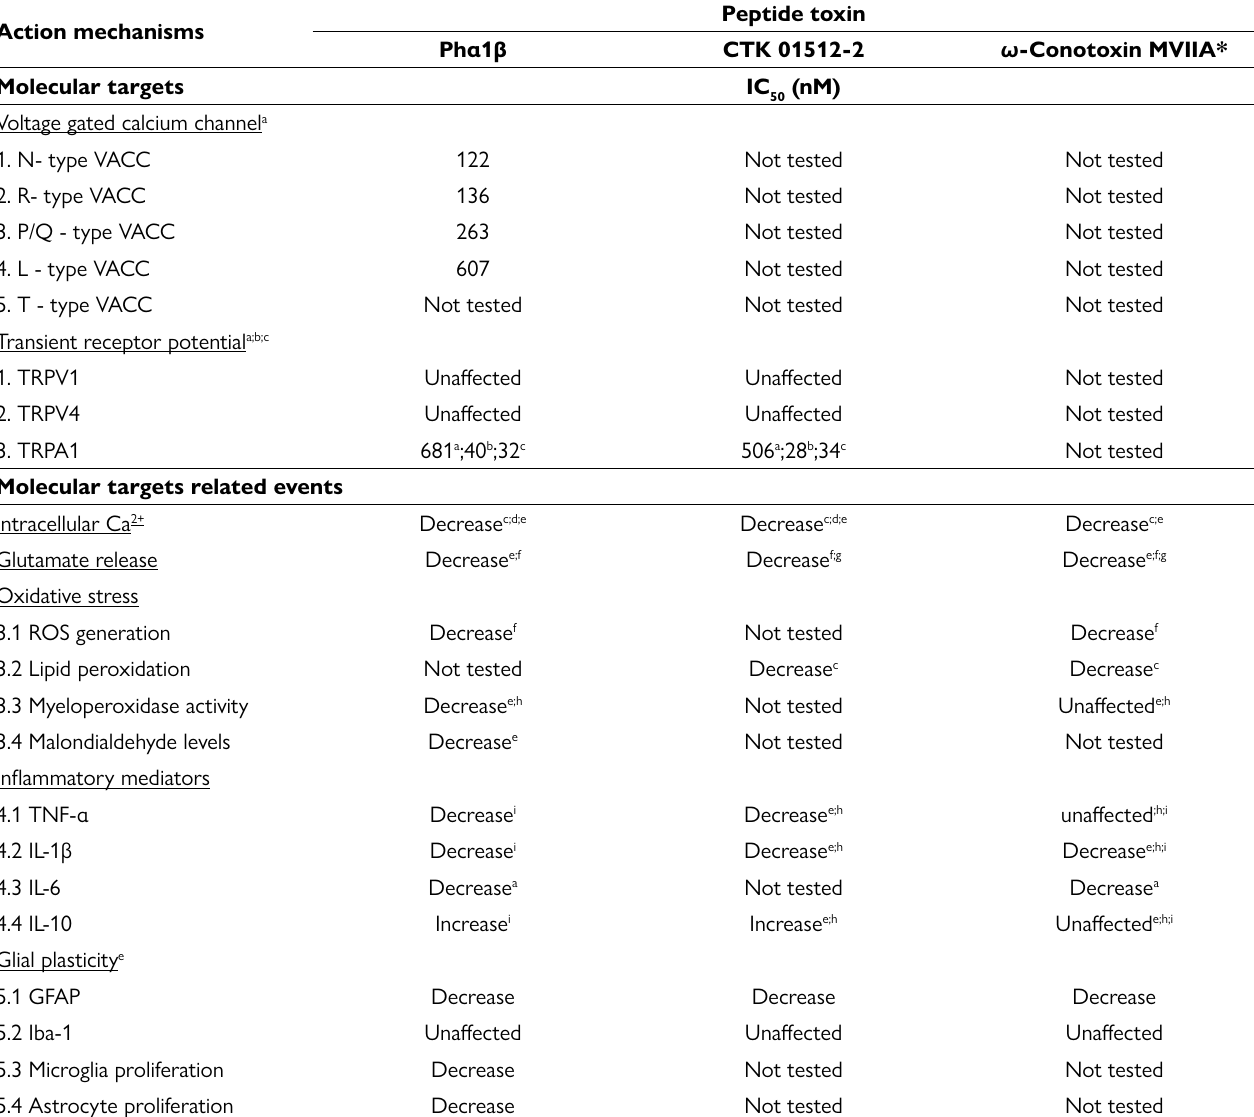
Table 3. Phα1β, CTK 01512-2 and ω -conotoxin MVIIA (Ziconotide, Prialt®) pain pathway action mechanisms. Action